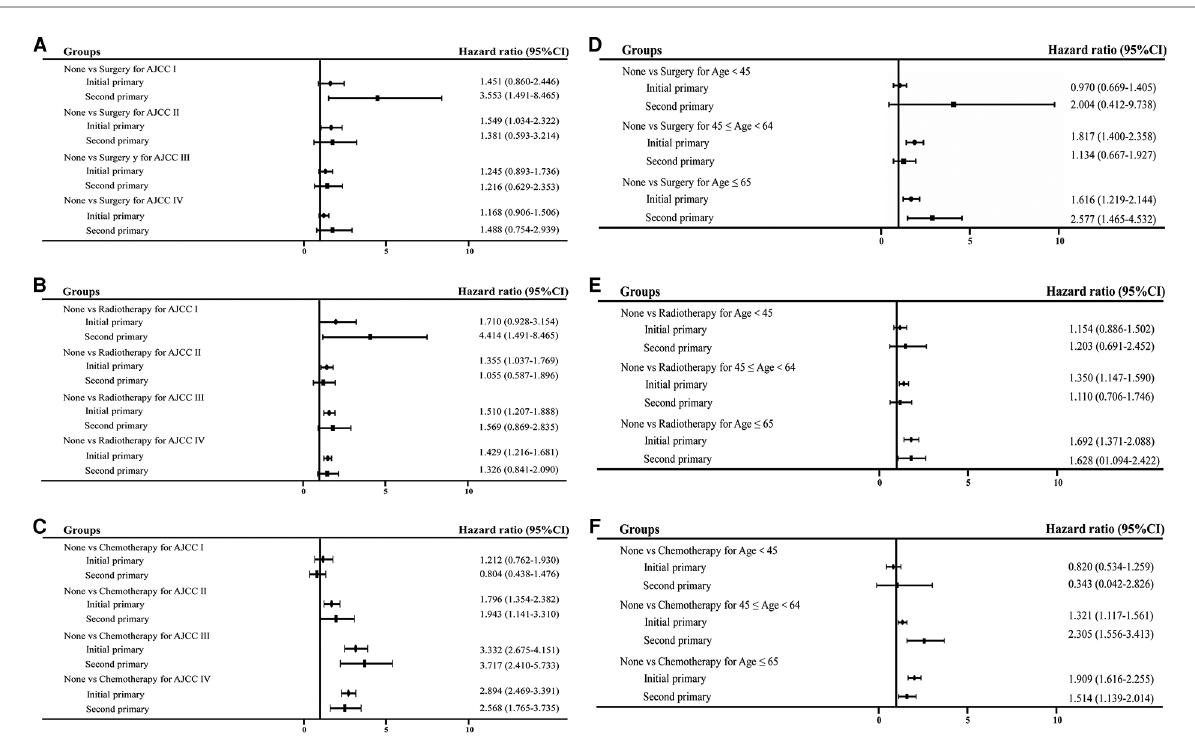
FIGURE 5 Forest plot of HR and 95% CI in overall mortality between initial and second primary patients strati fi ed by different subgroups. ( A ) Comparison of surgery performance in different AJCC stage; ( B ) comparison of radiation performance in different AJCC stage; ( C ) comparison of chemotherapy treatment in different AJCC stage; ( D ) comparison of surgery performance in different age at diagnosis; ( E ) comparison of radiation performance in different age at diagnosis; ( F ) comparison of chemotherapy treatment in different age at